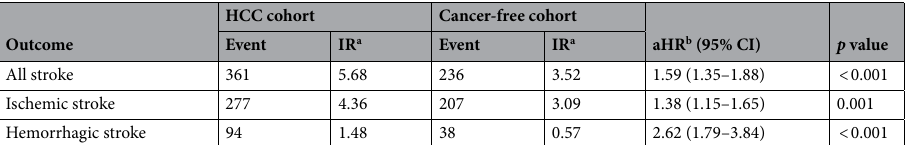
Table 2. Risk of stroke in patients with hepatocellular carcinoma compared with the cancer-free cohort after propensity score matching. a IR per 1000 person-years. b The hazard ratios were calculated using a multivariable Cox proportional hazards regression model with adjustments for income, CCI, comorbidities, and medication use listed in Table 1. aHR adjusted hazard ratio, CI confidence interval, HCC hepatocellular carcinoma, IR incidence rate, CCI : Charlson comorbidity